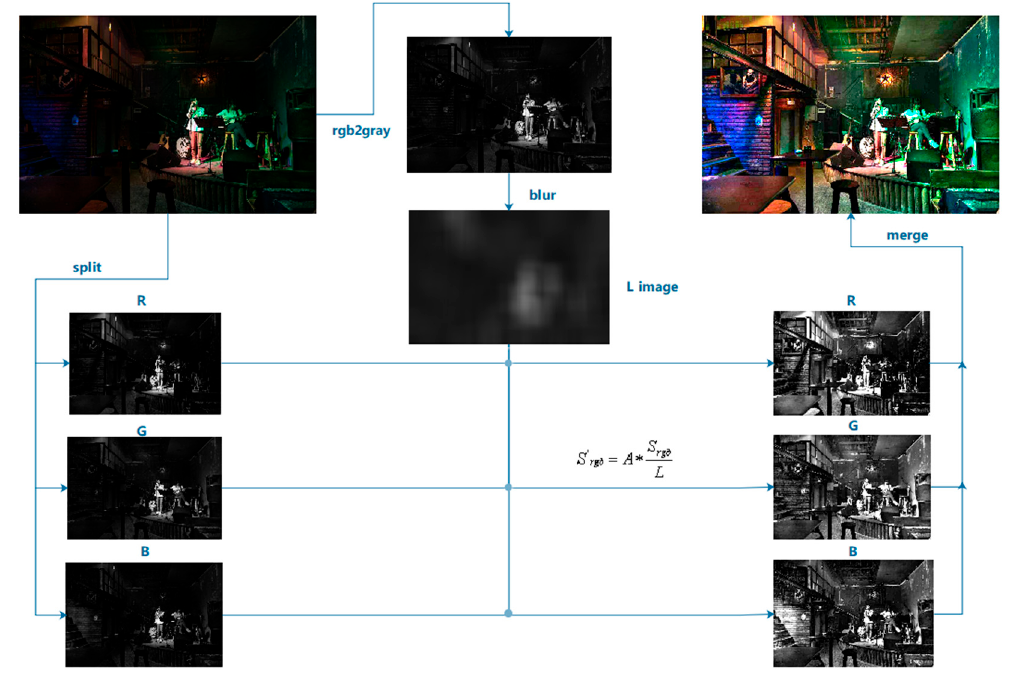
Figure 18. Low illumination color image enhancement process.